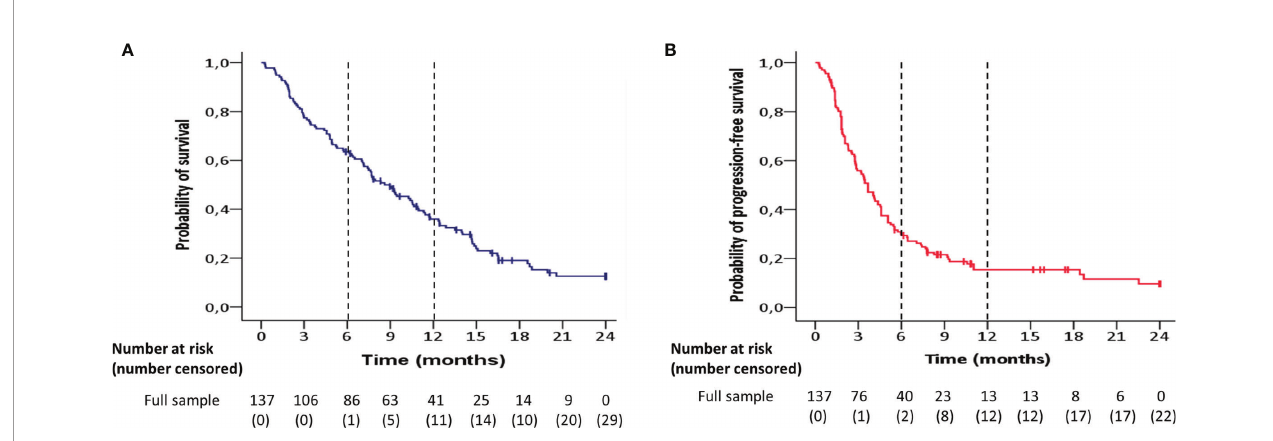
FIGURE 1 | Kaplan-Meier estimates of (A) overall survival and (B) progression-free survival for the entire patient group